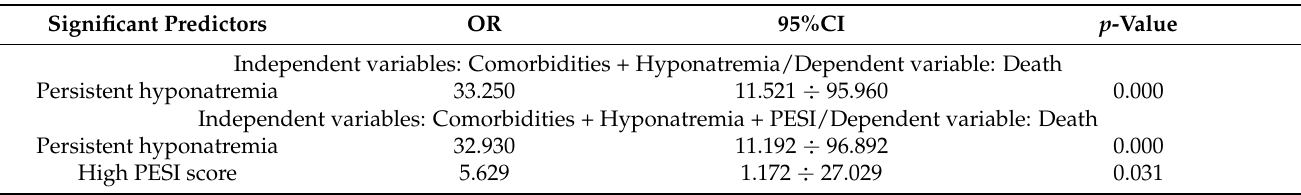
Figure 2. Recurrence rate of pulmonary embolism (PE) in the study cohort at 6, 12 and 24 months. Table 6. Results of binary logistic regression analysis for different combinations of predictors and clinical outcome–patients with persistent hyponatremia vs. patients with